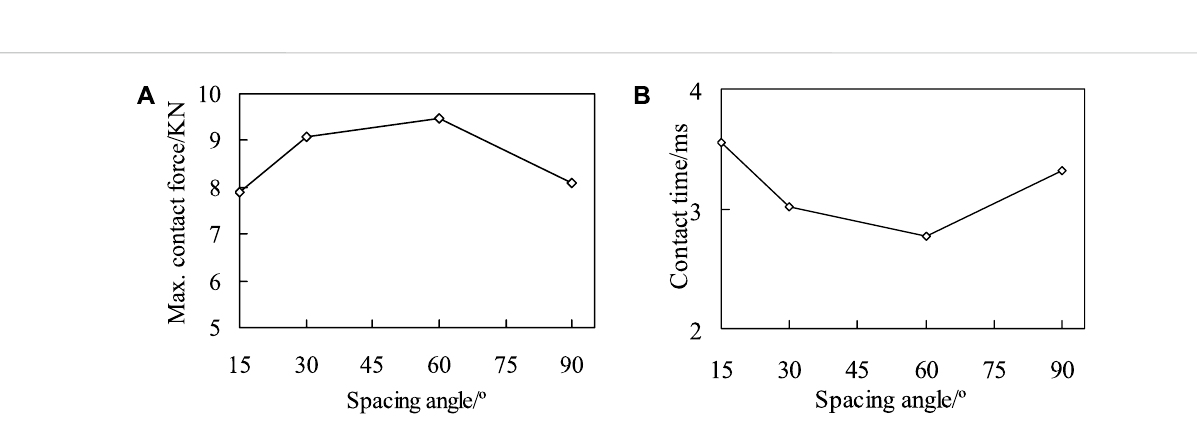
of contact load during the impact process. And there are also differences in the timing of the peak point of contact load for the four models. The Sample90 model fi rst appears the peak point, and the Sample60 fi nally appears the peak point.